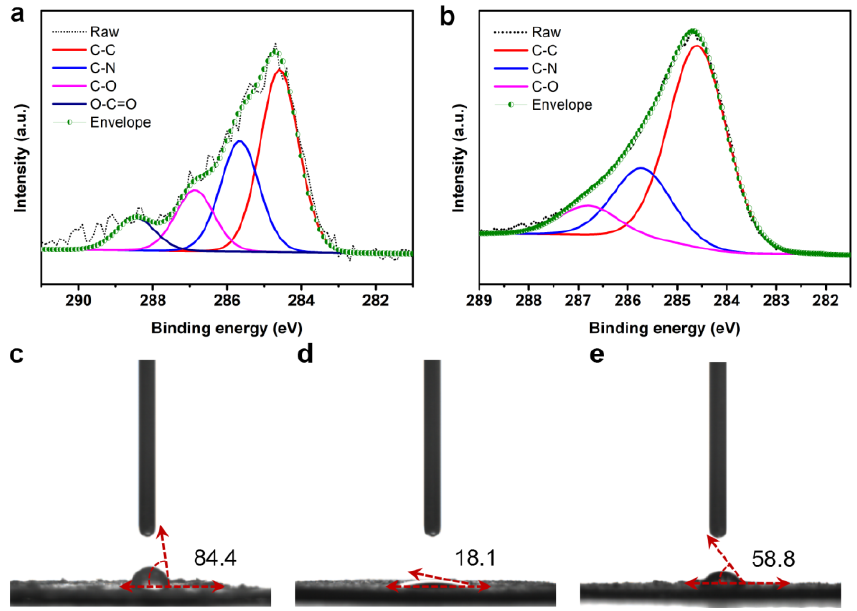
Figure 4. XPS survey spectra of C 1s of fiber/C1 ( a ), and fiber/C2 ( b ); water contact angle of the fiber/epoxy composite ( c ), fiber/C1 ( d ), and fiber/C2 ( e ).